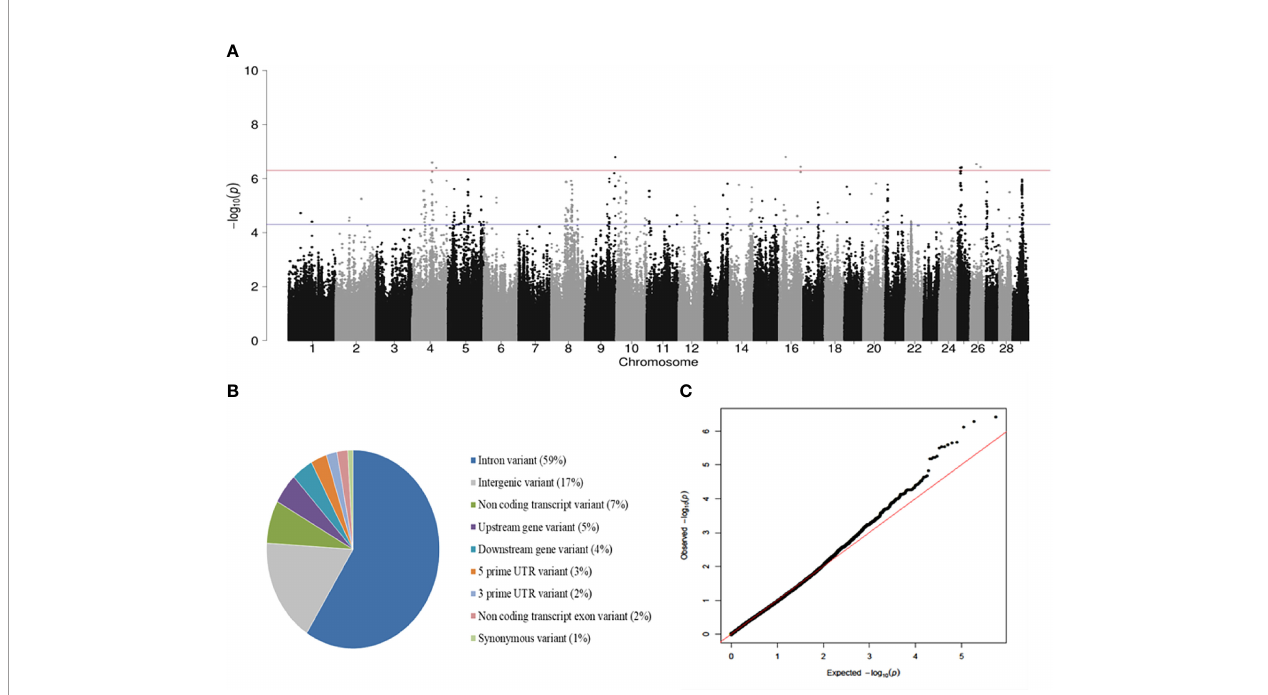
FIGURE 1 | GWAS for PTB tolerance. (A) Manhattan plots showing – log 10 ( P -values) of association between every single SNP and phenotype. The associations between host genetic and tolerance were investigated using the genotypes from 277 Spanish Holstein cows with two distinct phenotypes: cases) positive PCR and culture result without lesions (N = 24), and controls) negative PCR and culture result with PTB-associated lesions (N = 253). Each dot represents the result from the test association for a single SNP. The horizontal red line shows – log 10 (5 × 10 -7 ) and the blue line – log 10 (5 × 10 -5 ). (B) Genomic distribution of the SNPs associated (FDR ≤ 0,05, P < 5 × 10 -7 ) with tolerance according to the Ensembl Variant Effect Predictor (VEP). (C) Quantile-quantile plot compared the observed distribution of – log ( P -values) to the expected values under the null